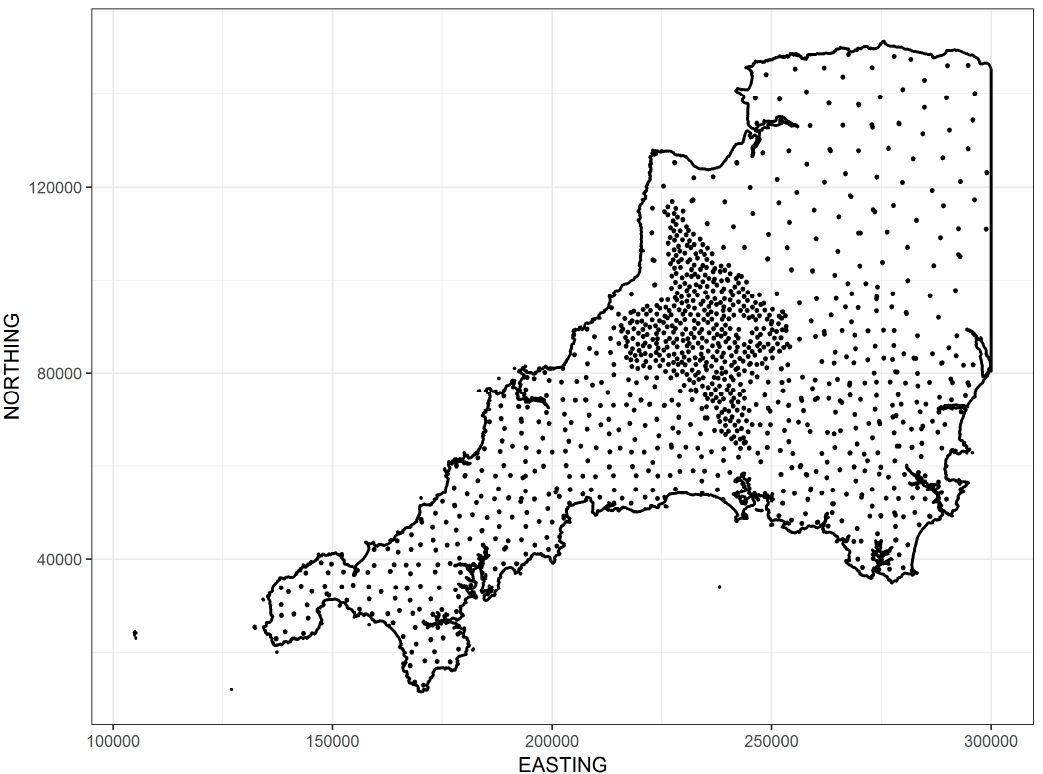
Figure 2. Sample locations for the geochemical baseline mapping programme (GBASE) south-west England soils.